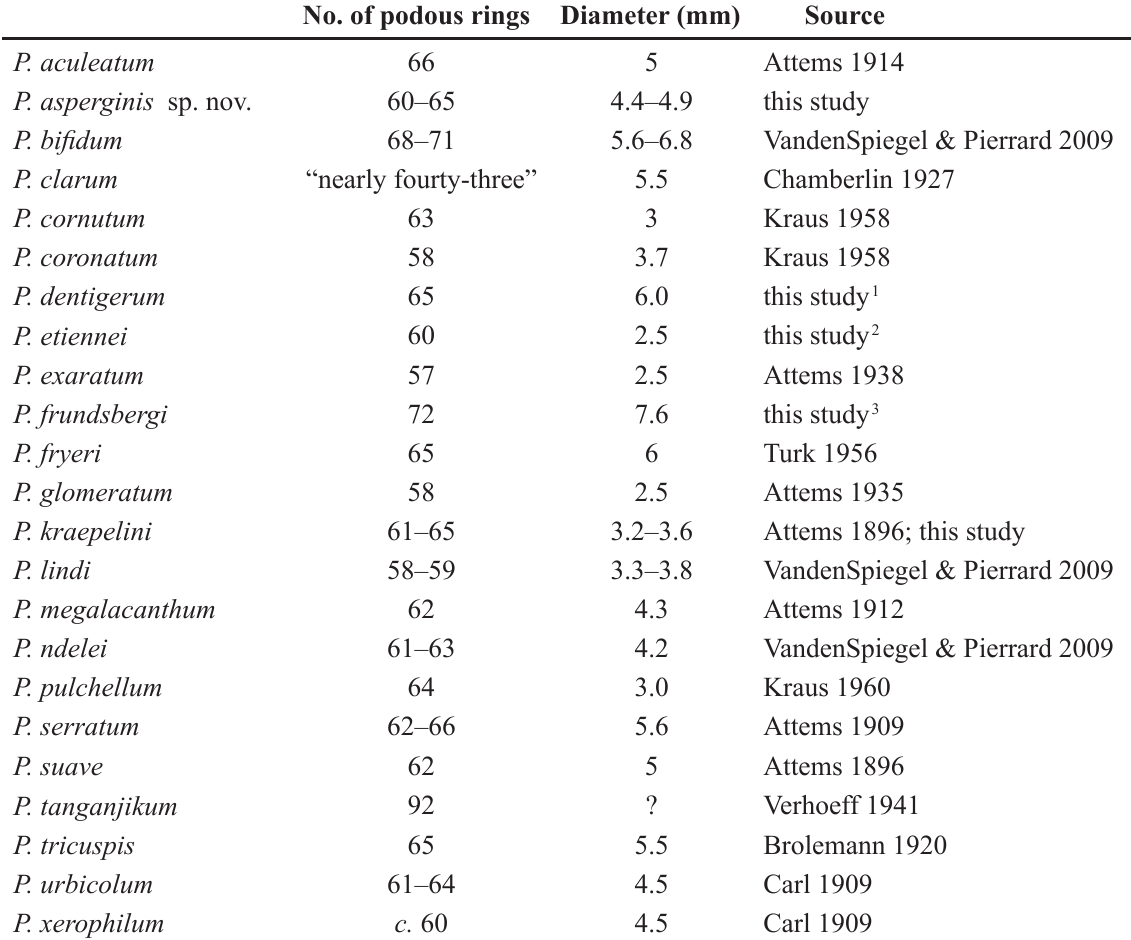
Table 1. Numbers of podous rings and body diameter of adult males of species of Prionopetalum . One has been subtracted from published “segment” numbers because these include the telson. None of the species are known to have apodous rings between the last podous ring and the